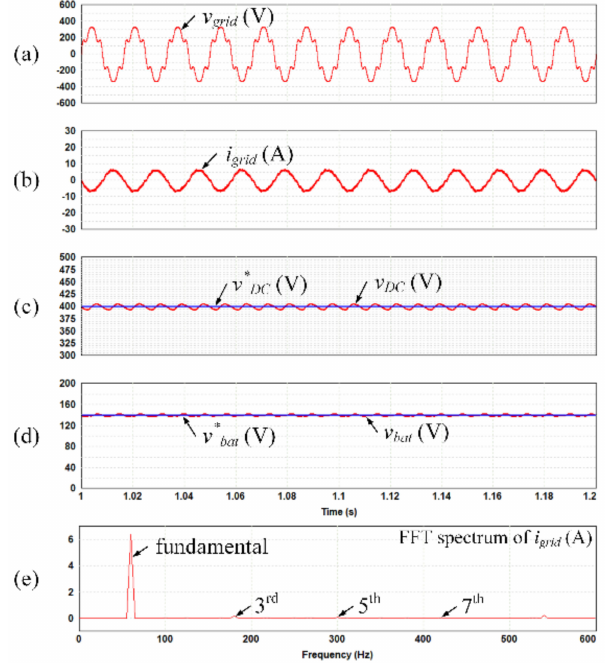
Figure 10. Simulation results of integrated OBC with the proposed reduction method of third-order and sixth-order harmonic components: ( a ) voltage and ( b ) current of the single-phase grid source, ( c ) DC-link voltage and reference DC-link voltage, ( d ) voltage of the battery and reference voltage of the battery, and ( e ) FFT spectrum of current of the single-phase grid source.